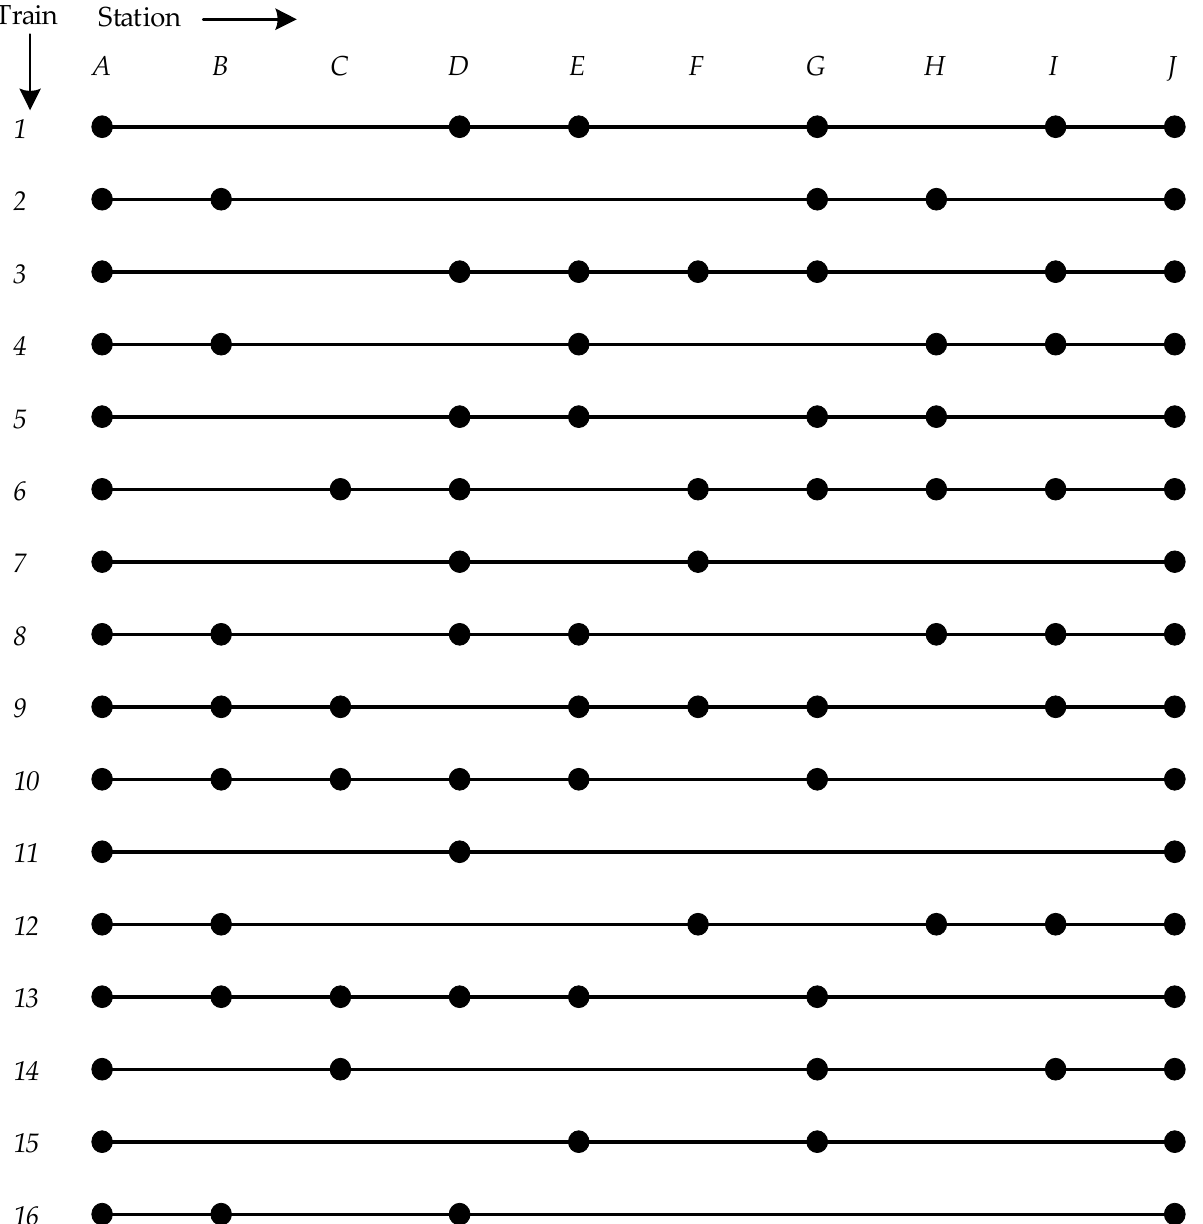
Figure 5. Optimized train stop plan in the experiment.